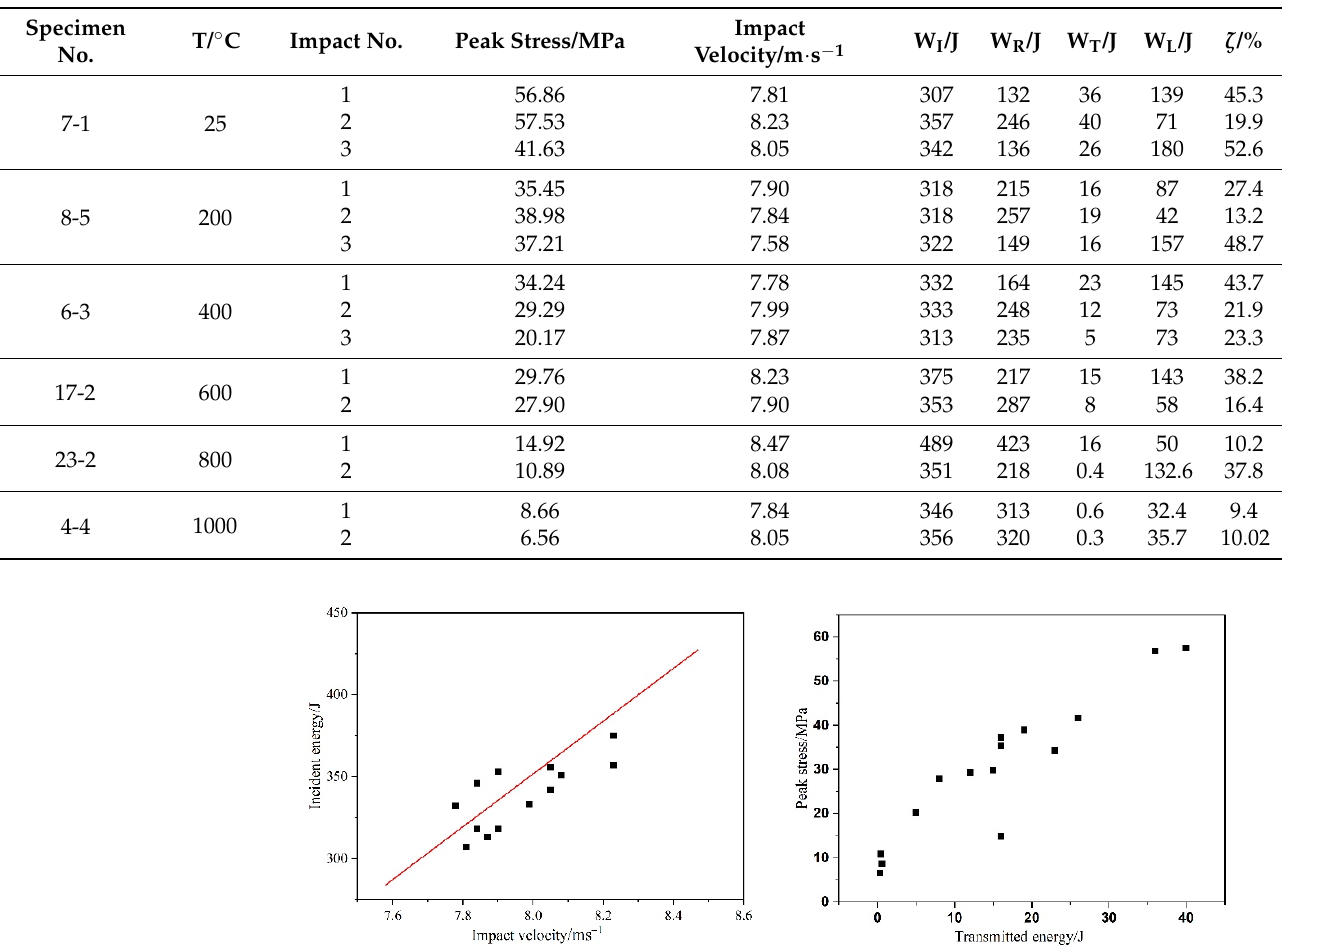
Table 3. Calculation of cyclic impact energy of sandstone after different temperatures.